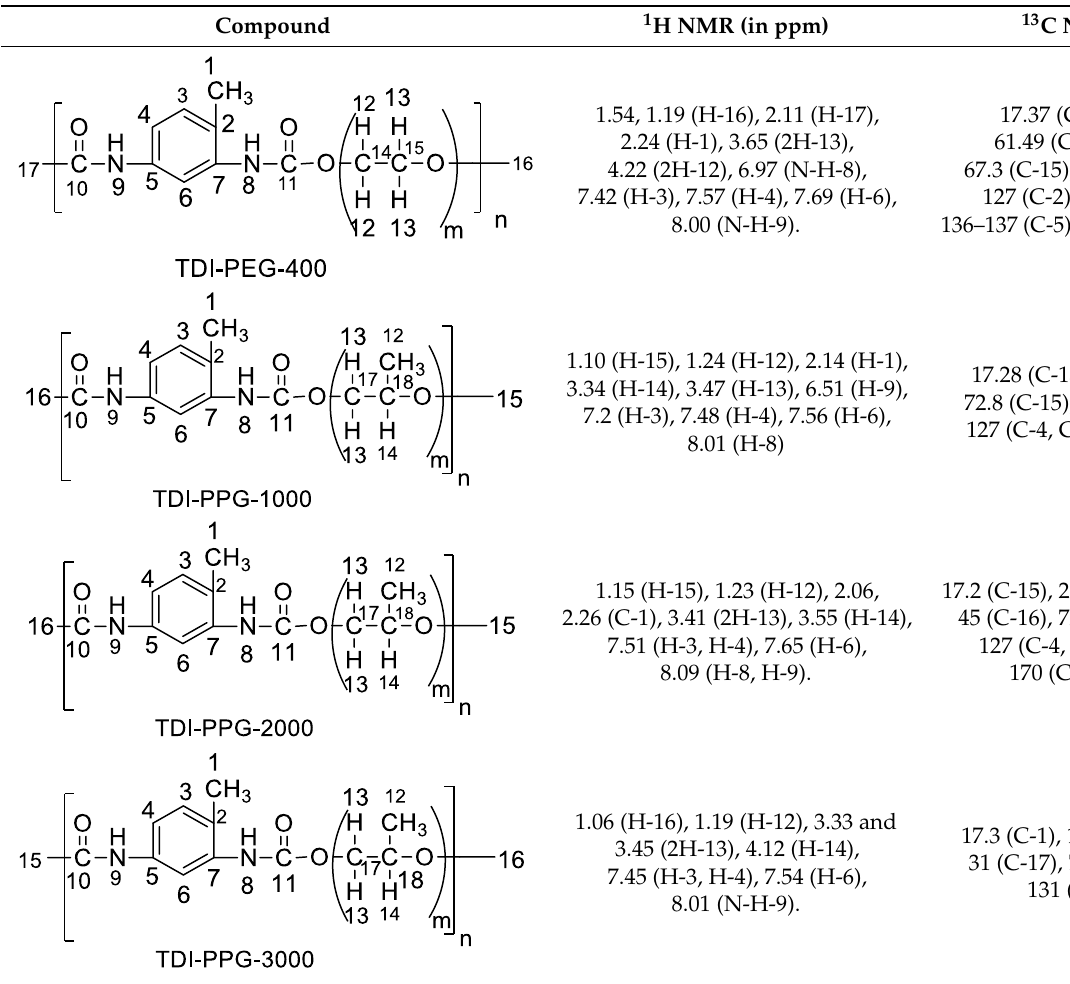
Figure 2. ( A ) 1 H NMR spectrum of TDI-PPG-1000, ( B ) 1 H NMR spectrum of TDI-PPG-2000, ( C ) 13 C NMR spectrum of TDI-PEG-400 and ( D ) 13 C NMR spectrum of TDI-PPG-2000.